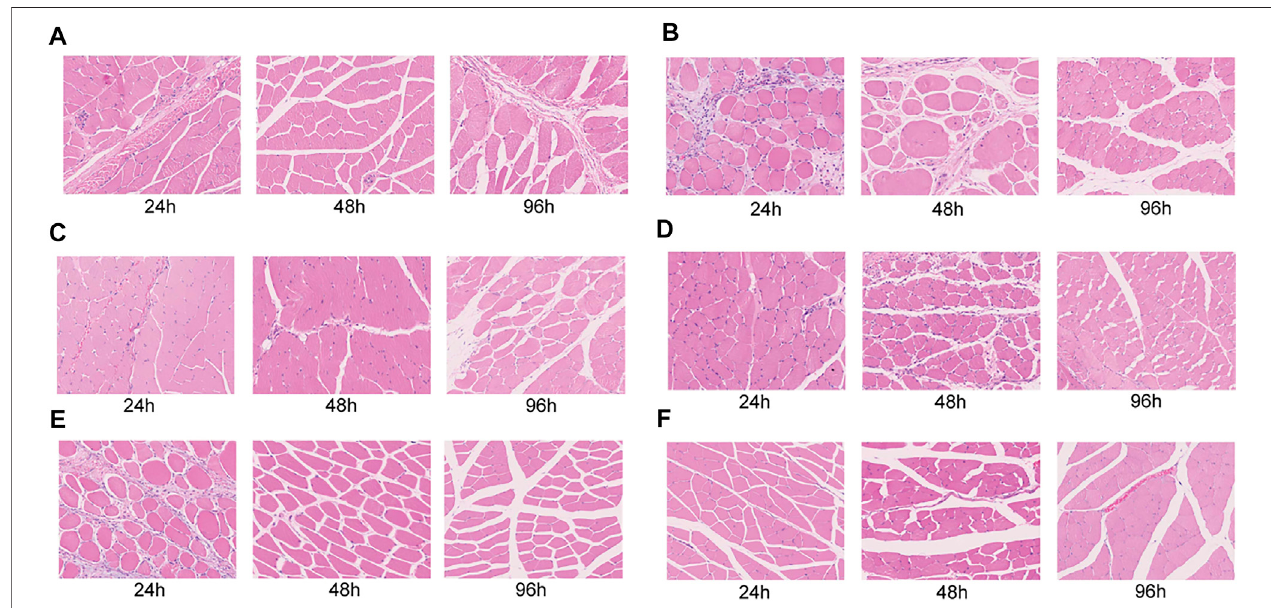
FIGURE 5 | Histopathological evaluation of the leg muscular tissue after injected fl urbiprofen ester microspheres by intramuscular and intravenous at 24, 48, and 96 h. (A) The blank control of normal rats injected saline solution; (B) The negative control of the closed femoral shaft fracture injected saline solution; (C) The positive control of the closed femoral shaft fracture by intravenous injection fl urbiprofen ester microspheres 4.5 mg/kg; (D) The experiment group of the closed femoral shaft fracture by intramuscular injection fl urbiprofen ester microspheres 2.25 mg/kg and; (E) 4.5 mg/kg; (F) 9 mg/kg.